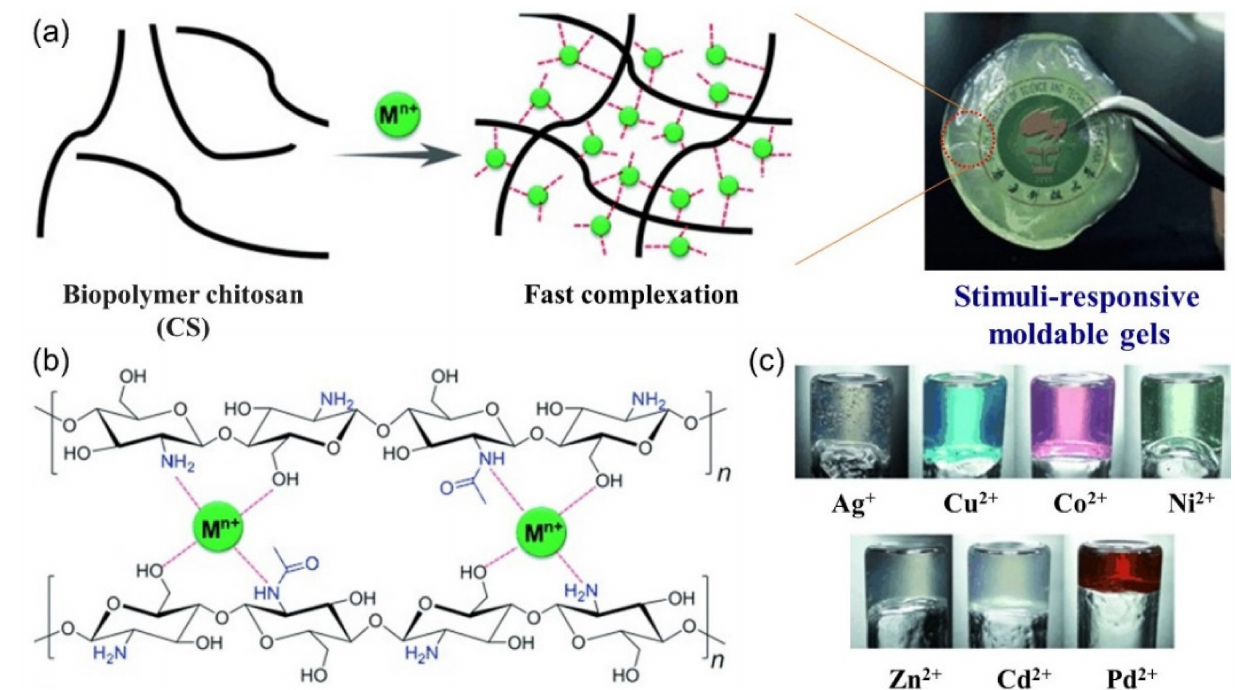
Figure 46. ( a ) Schematic representation of polymer-network hydrogels cross-linked via ultrafast complexation of metal ions and chitosan chains in water. ( b ) Chemical structures of chitosan and their interwoven networks are driven by the complexation between metal ions and OH and NH 2 groups in the chitosan chains. ( c ) The complexation in ( b ) leads to the formation of hydrogels. Reprinted with permission from Ref. [72]. Copyright (2015), John Wiley and